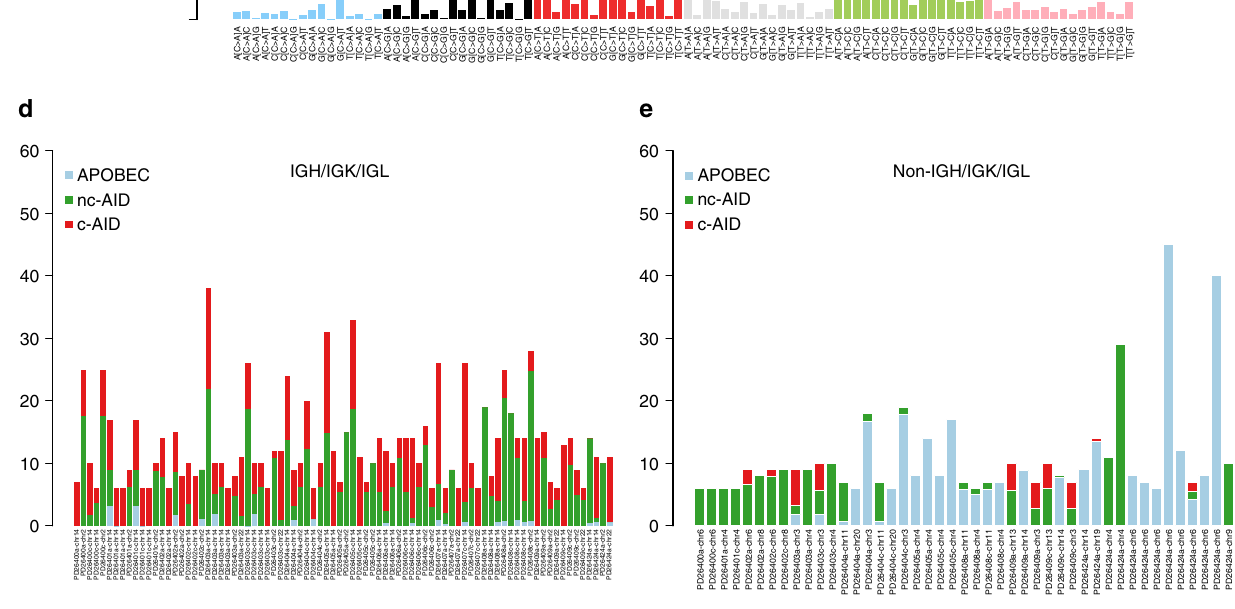
Fig. 5 The prevalence, role and origin of localized hypermutation in MM. a Circos plot representing the distribution of all kataegis event among smoldering MM (blue dots) and symptomatic MM (orange dot). b Kataegis events were frequently found near rearrangements (black line representing the actual distance from the breakpoint). This association was higher than expected by chance (gray line). The rearrangements are broken down by type (blue line = inversion, red line = deletions, green line = ITD, and purple line = translocation). c The 96-mutational class histogram of the canonical AID signature extracted by NNMF on localized hypermutation events. d , e The absolute contribution of each involved mutational signature among all localized hypermutation regions within the IGH/IGK/IGL ( d ) and the non-IGH/IGK/IGL ( e